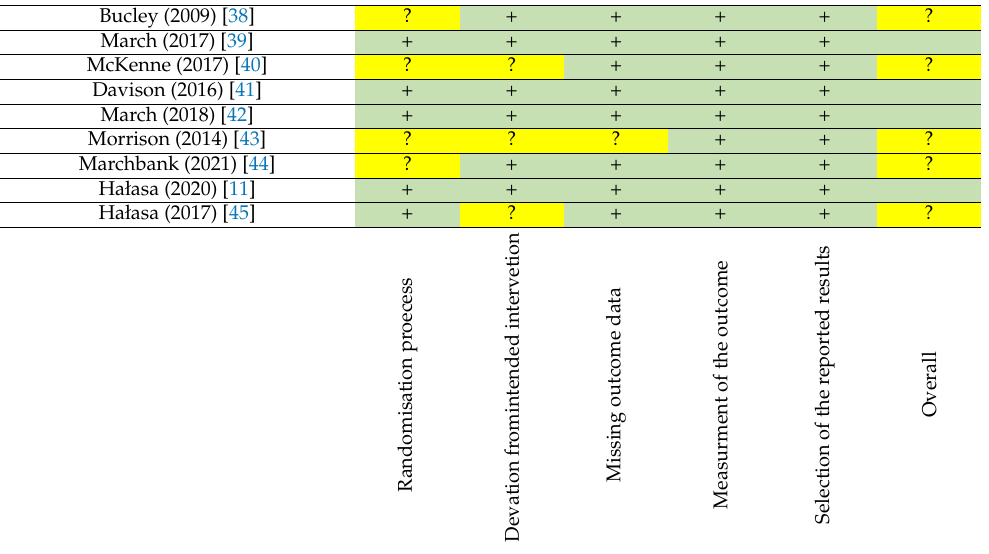
Table 2. Cochrane Collaboration Risk-of-Bias Tool [37].